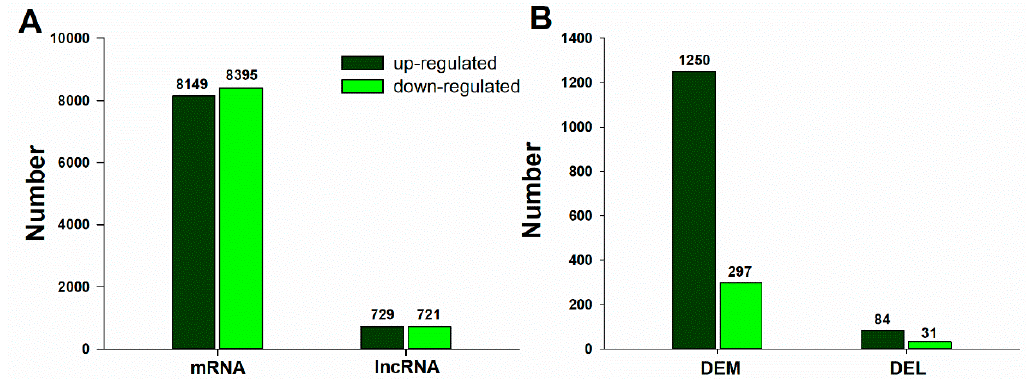
Figure 5. Differentially expressed lncRNAs and mRNAs in the leaves of a trifoliate orange seedling under B deficiency stress. ( A ) Total differentially expressed mRNAs and lncRNAs; ( B ) Significantly differentially expressed mRNAs and lncRNAs (|log 2 FC(BD/CK)| ≥ 2 as cutoff).